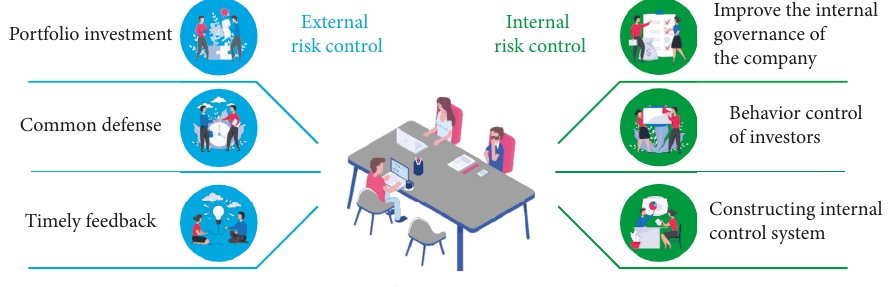
Figure 1: Risk management